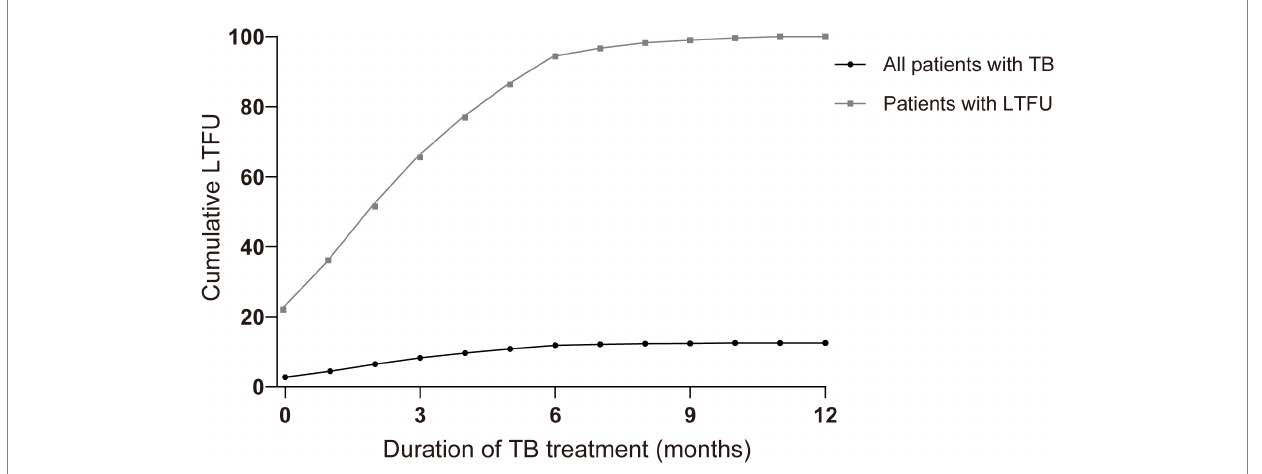
FIGURE 2 Comparison of cumulative percentage and event occurrence time of loss-to-follow-up (LTFU) cases in all patients with tuberculosis (TB) and patients with LTFU only over the treatment course (months). Nb. All patients with TB ( n = 24,265), patients with LTFU ( n =